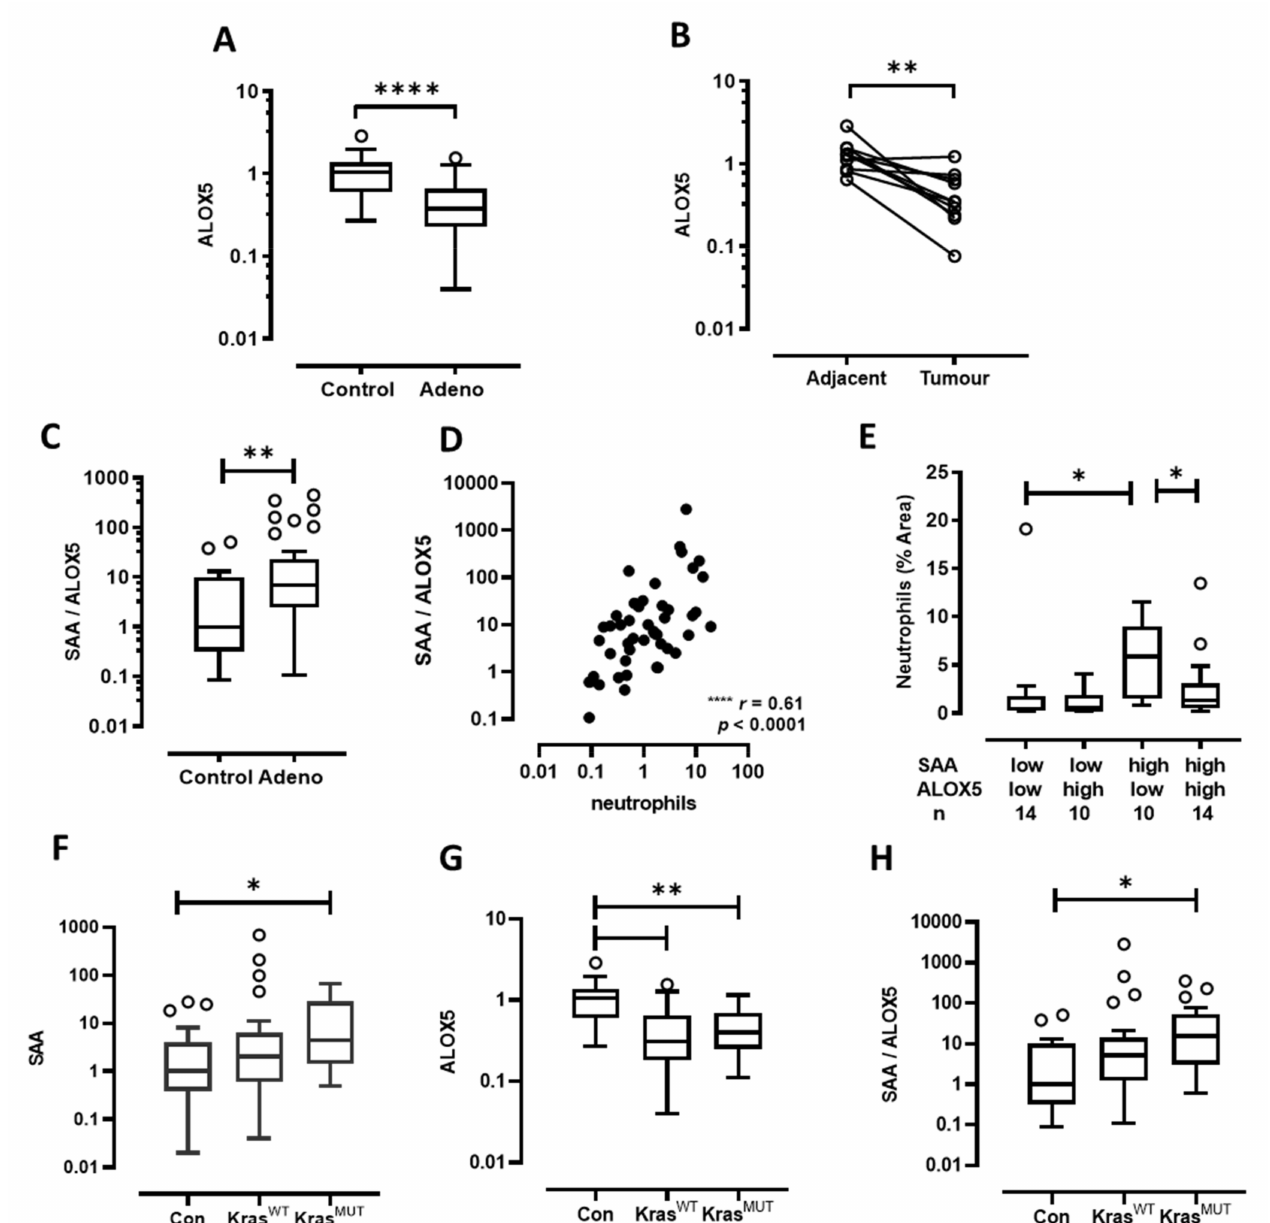
Figure 2. The SAA/ALOX5 ratio is elevated in lung adenocarcinoma. ( A ) ALOX5 transcript levels were significantly reduced in lung adenocarcinoma tumour biopsies as assessed by RTqPCR, which was confirmed by ( B ) paired analysis tumour and adjacent control samples. ( C ) The SAA/ALOX5 ratio was significantly increased in tumour biopsies and ( D ) Spearman correlation identified a strong positive association between the SAA/ALOX5 ratio and tumour infiltrating neutrophils ( r = 0.61, p < 0.0001). ( E ) The adenocarcinoma cohort was stratified into four groups based on their upper and lower SAA and ALOX5 expression levels (50th percentile cut-off). ( F ) SAA expression was assessed according to KRAS mutation status. ( G ) ALOX5 expression was assessed according to KRAS mutation status. ( H ) The SAA/ALOX5 ratio according to KRAS mutation status. **** p < 0.0001, ** p < 0.01, * p <